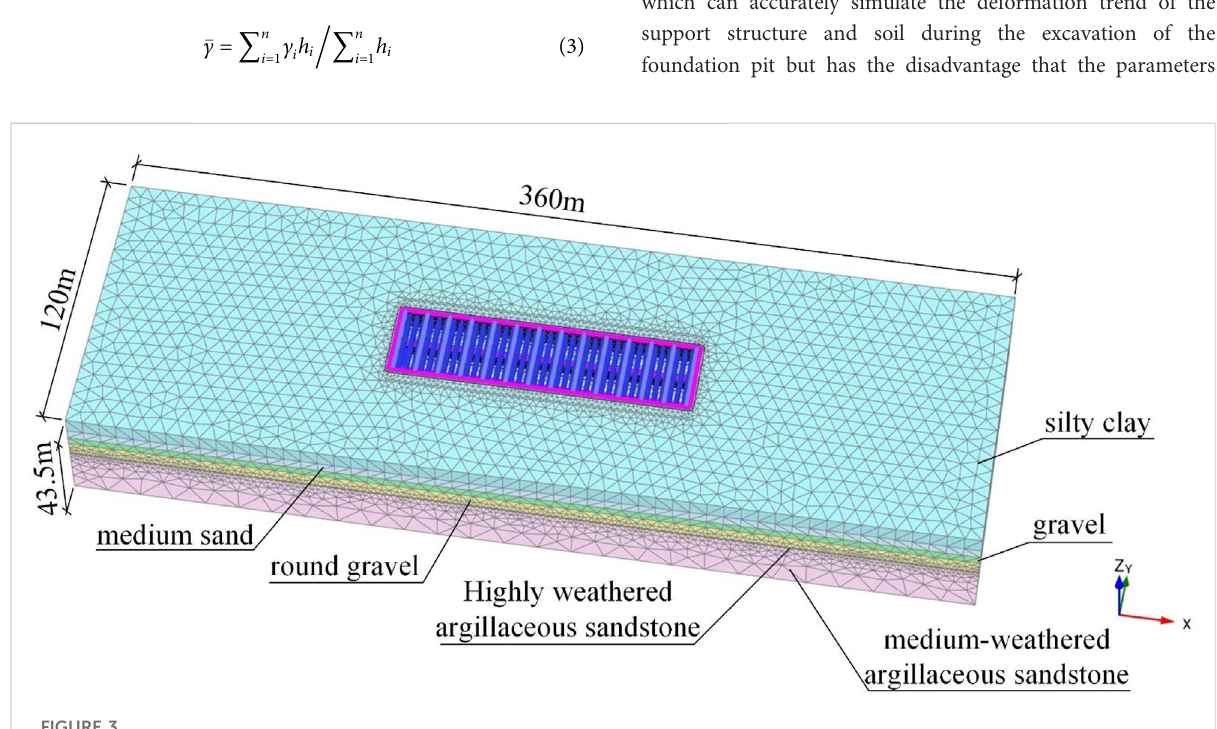
FIGURE 3 Finite element